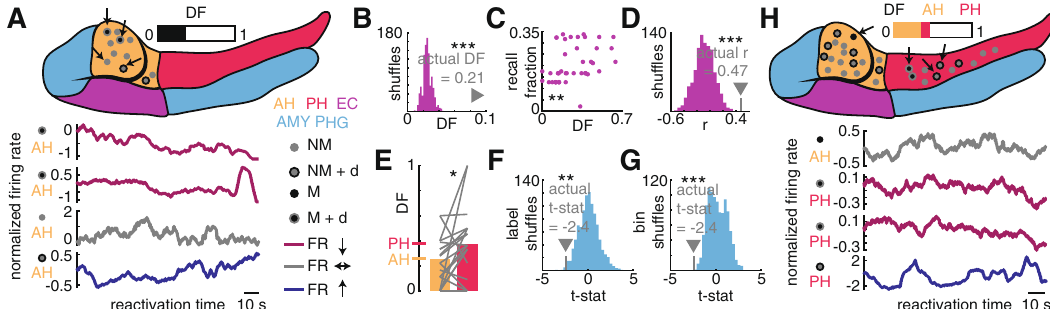
Fig.4|Assemblydriftpredictssuccessfulmemoryandoccursmorefrequently in the posterior compared to the anterior hippocampus. A Top, schematic of the anterior(AH) and posterior (PH)hippocampus, entorhinalcortex (EC), amygdala (AMY), and parahippocampalgyrus (PHG) with allrecorded neurons from anexamplesessionsuperimposed.Theexact neuron locationisforillus- trationonly.Bothmember(M)andnon-member(NM)neuronsaredisplayedfor anexampleassemblyandneuronsdemonstratingdriftacrossactivationevents (+d)arenoted.Thedriftfractionisdisplayedabovetheschematic.Bottom,the fi ring rate of four example neuronsfrom the recording session acrossall assembly activationevents, showing examples of neuronsthatdecrease (red) and increase (blue) theircontributionand thatremain stable (gray)acrossthe session. Fordisplay purposesonly,the fi ring rate curve issmoothed with a10s window and normalized and set the value attime zero to 0. The anatomical regionandcategoryofneuronscorrespondingtothedisplayeddatawereshown totheleftoftheplots. B Comparisonoftheobserveddriftfraction(DF)acrossall assemblies to a nulldistribution obtained byshuf fl ing the activationbinorder